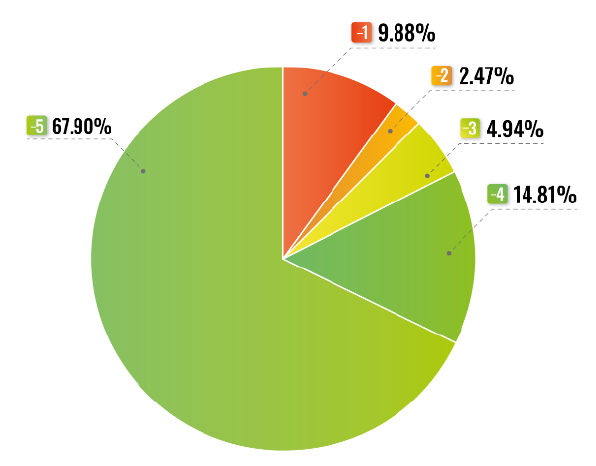
Figure 1. RASS scores in the study group ( n = 81).